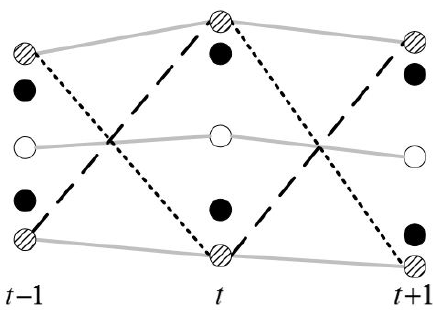
Figure 2. Illustrative example of net load change and reserve requirement.